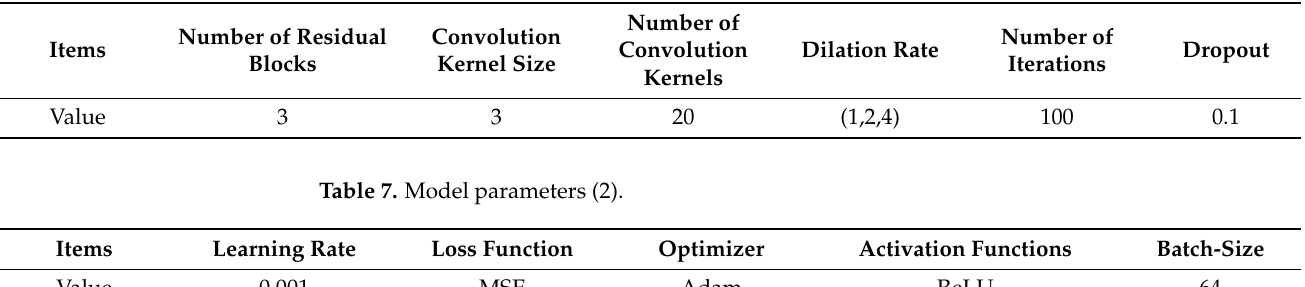
Table 6. Model parameters (1).